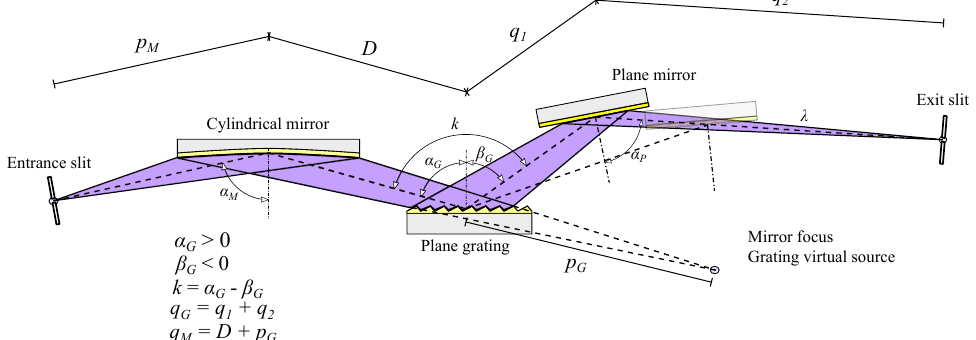
Figure 1. Tangential layout of the monochromator referred to the dispersion (spectral plane). The cylindrical mirror focus is placed after the grating. In order to maintain the final focal point at the same position, a variation of the grating subtended angle and the related translation and rotation of the plane mirror are required.